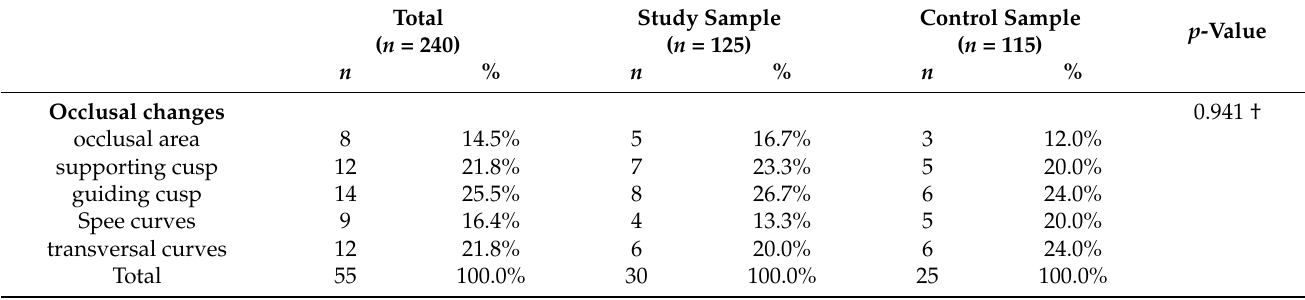
Table 7. Occlusal changes identified in the investigated samples.